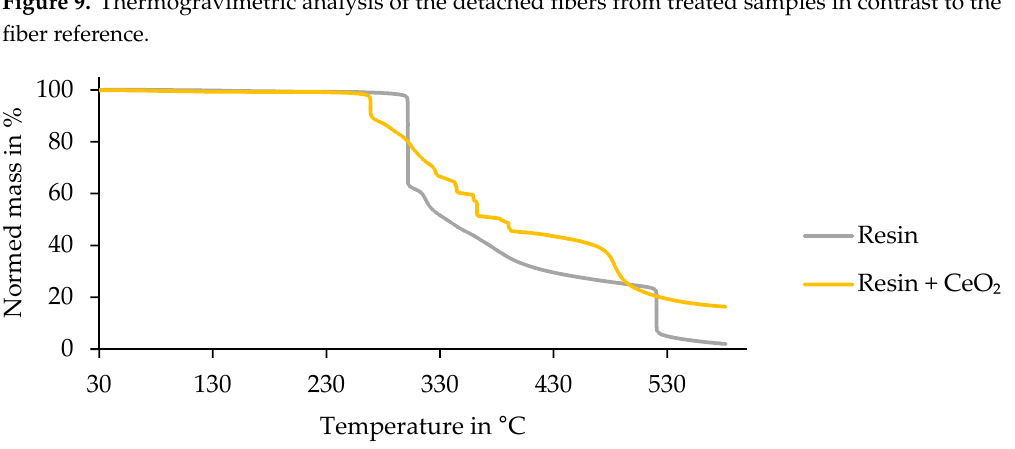
Figure 10. Thermogravimetric analysis of pure epoxy resin and pure epoxy resin and epoxy resin combined with the semiconductor CeO 2 .